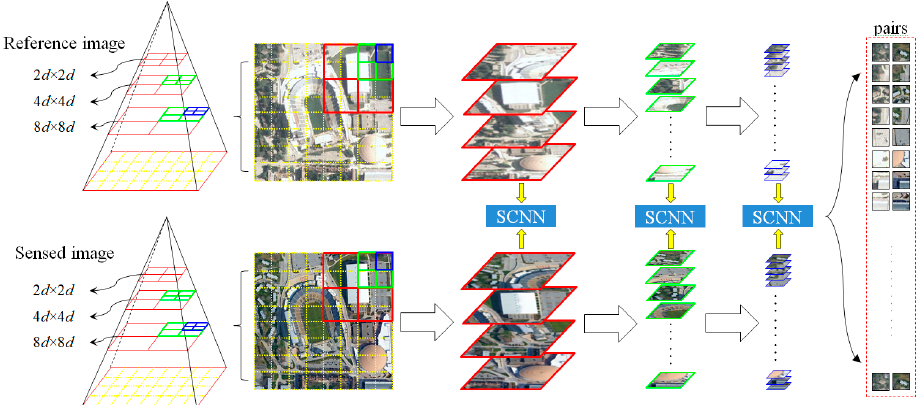
Figure 5. Patch comparison via GPCQ. The red rectangles are the patches, which are located at the top layer of Gaussian image pyramid. For example, four patches with sizes d × d are found in the top pyramid layer with size 2 d × 2 d , in which d is set to 96 pixels. The green and blue rectangles are the patches in the second and third layers, respectively. SCNN is used to compare the similarity between the patches in the reference and sensed images.